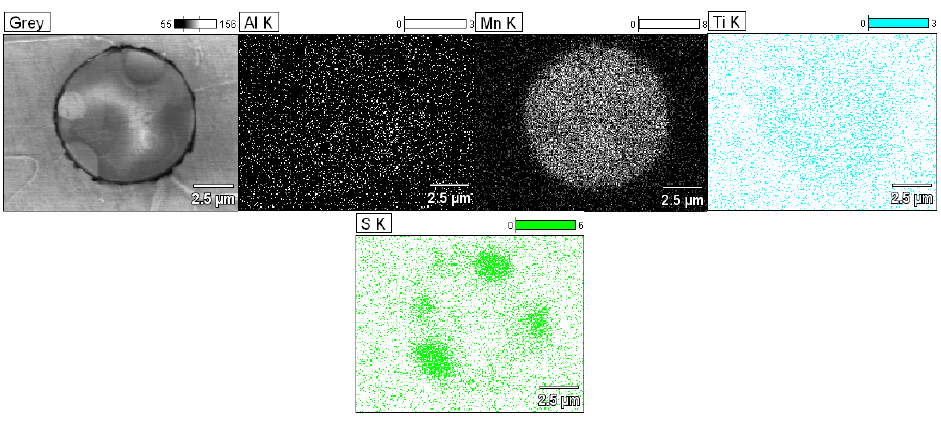
Figure 11. Surface scanning analysis of inclusions that free from Mg.